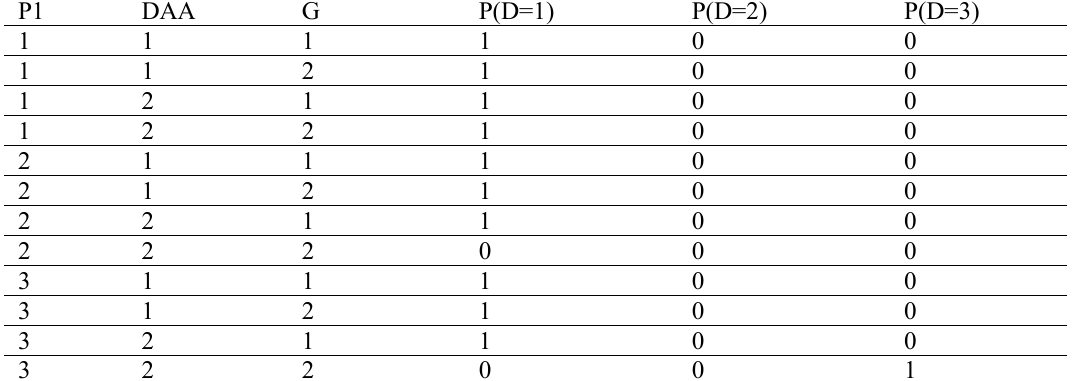
Table 10. States related to node D